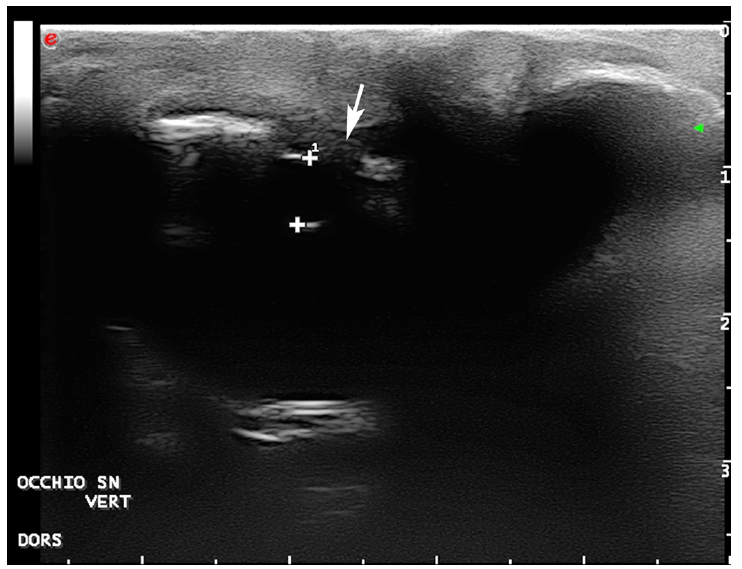
Figure 4. Ultrasonography of the left eye, vertical lateral-parasagittal scan: a fluid collection in the dorsal conjunctival space is present (arrow) delimitated ventrally from adhesion between the eyelid and cornea (arrowhead). More ventrally, a salt dacryolith is visible at the gland level (empty arrowhead). (Plus are electronic calipers to evaluate the eye depth 1 and height 2 )